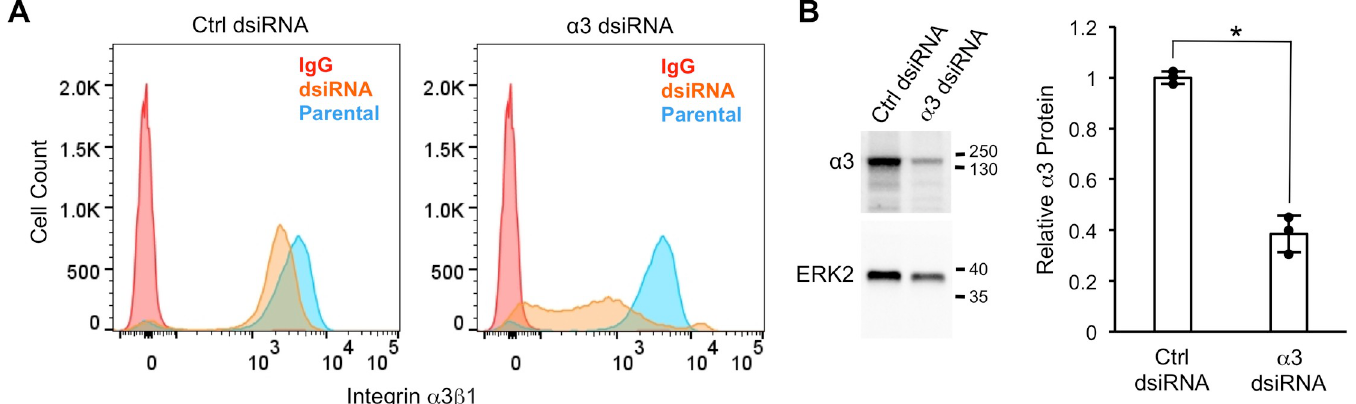
Fig 2. Suppression of the ITGA3 gene using dsiRNA leads to reduced cell surface levels of integrin α 3 β 1. MDA-MB-231 cells were transfected with control (Ctrl dsiRNA) or α 3-targeting dicer substrate siRNA ( α 3 dsiRNA), then assayed by flow cytometry with monoclonal antibody P1B5 to compare surface levels of α 3 β 1 (A), or by western blot to compare α 3 protein expression (B). (A) Graphs show data for cells transfected with control dsiRNA (orange peak, left graph) or α 3-targeting dsiRNA (orange peak, right graph). Flow cytometry was performed on parental cells with monoclonal antibody P1B5 as a positive control (shared blue peak for both graphs), or with IgG as a negative control (shared red peak for both graphs). (B) Western blot analysis to compare α 3 protein in cells treated with control dsiRNA or α 3-targeting dsiRNA; ERK2 , loading control; molecular weight markers are indicated (kDa). Graph shows quantification of relative α 3 protein, normalized to ERK2; n = 3; mean +/ − SD; � p < 0.05, two-tailed t-test.